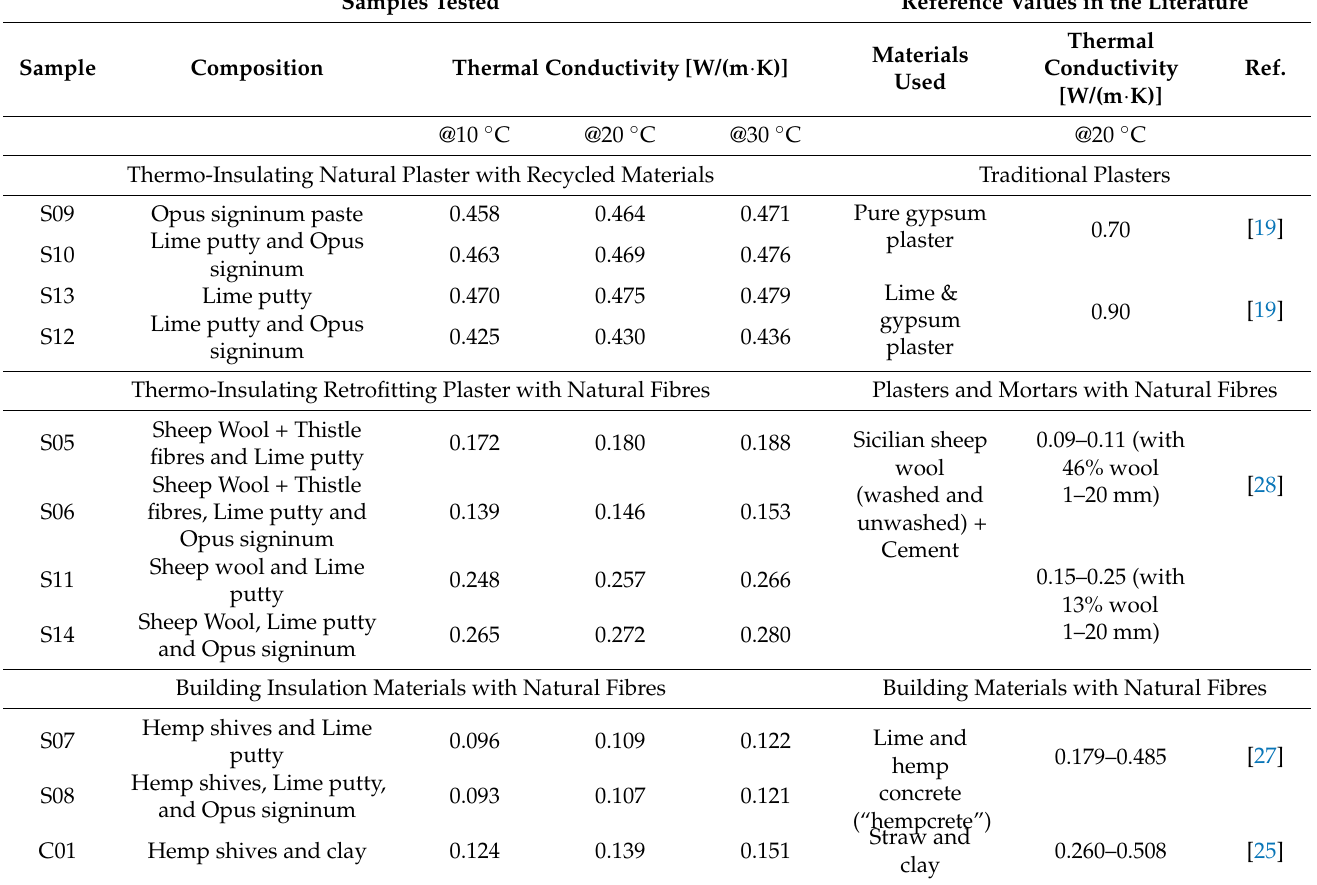
Table 5. Thermal conductivity of the mortar, plastering and insulation